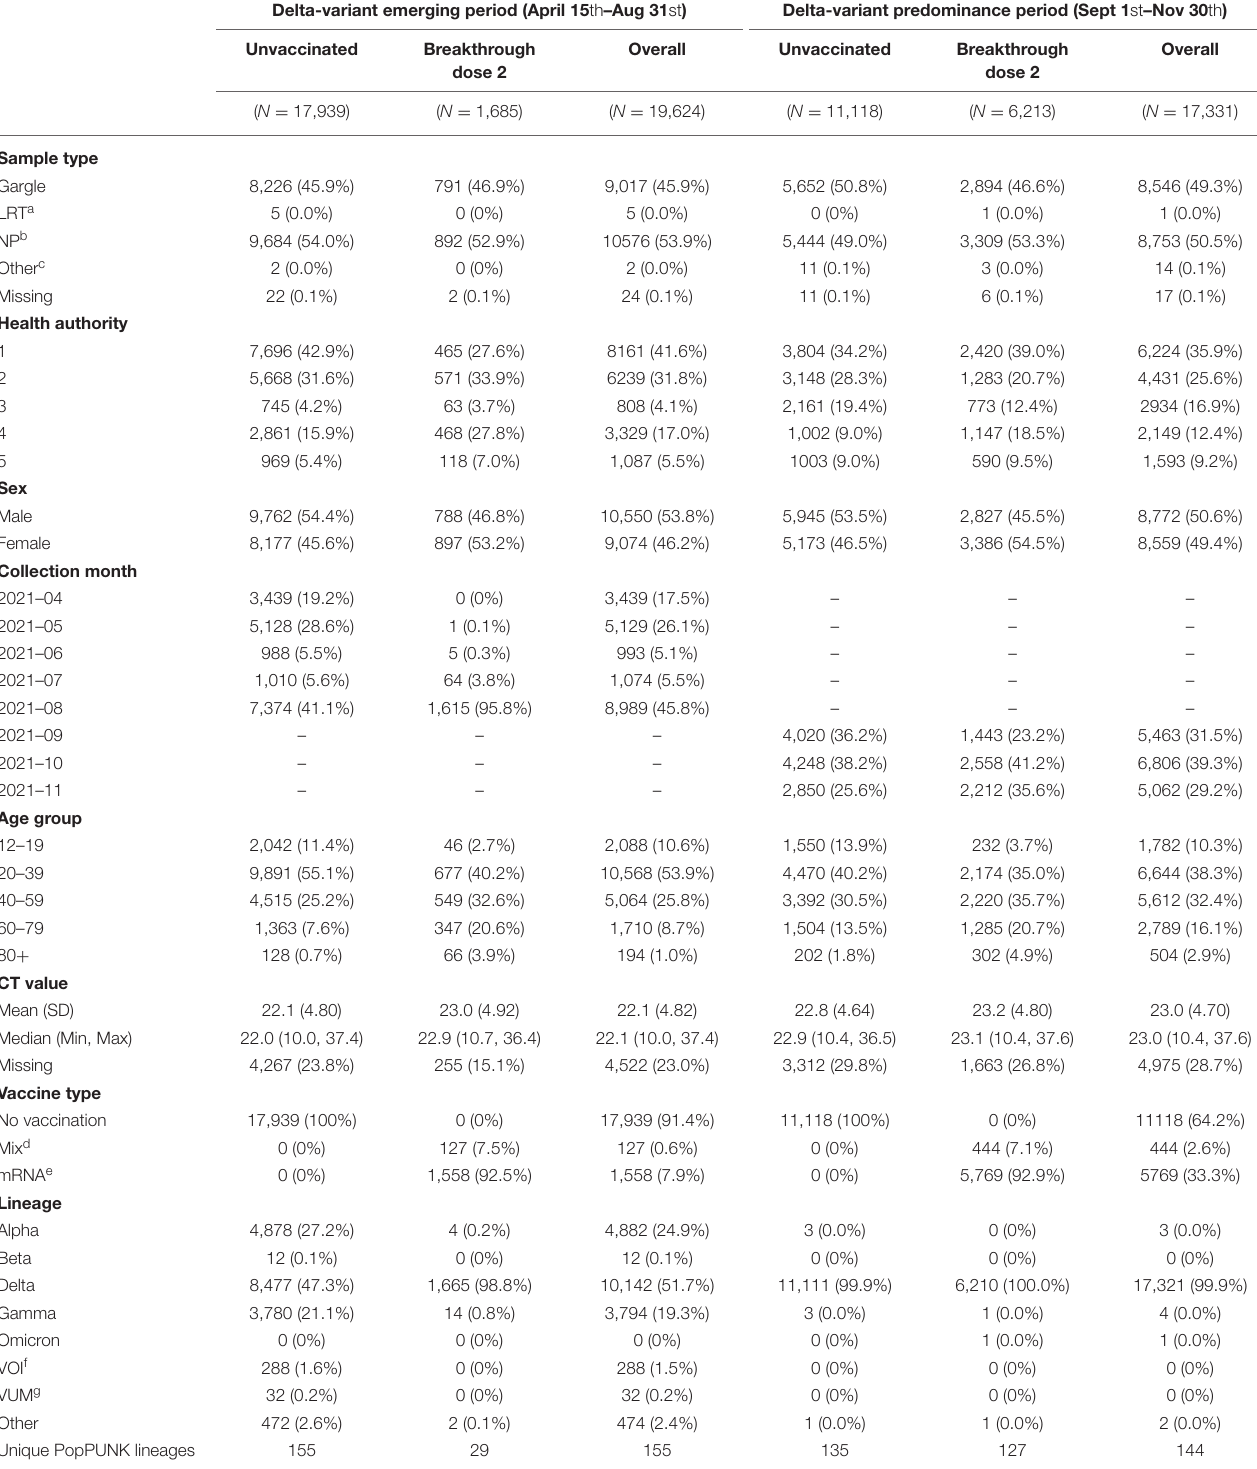
TABLE 1 | Characteristics of study population stratified by period and vaccination